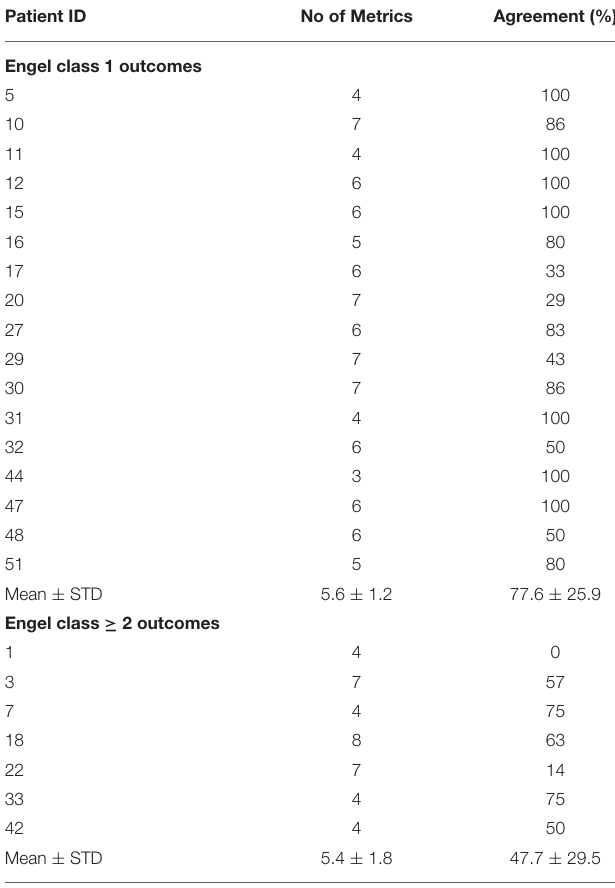
TABLE 4 | Agreement of laterality among neuroimaging metrics with results of standard clinical decision-making in cases with Engel class 1 vs Engel class ≥ 2